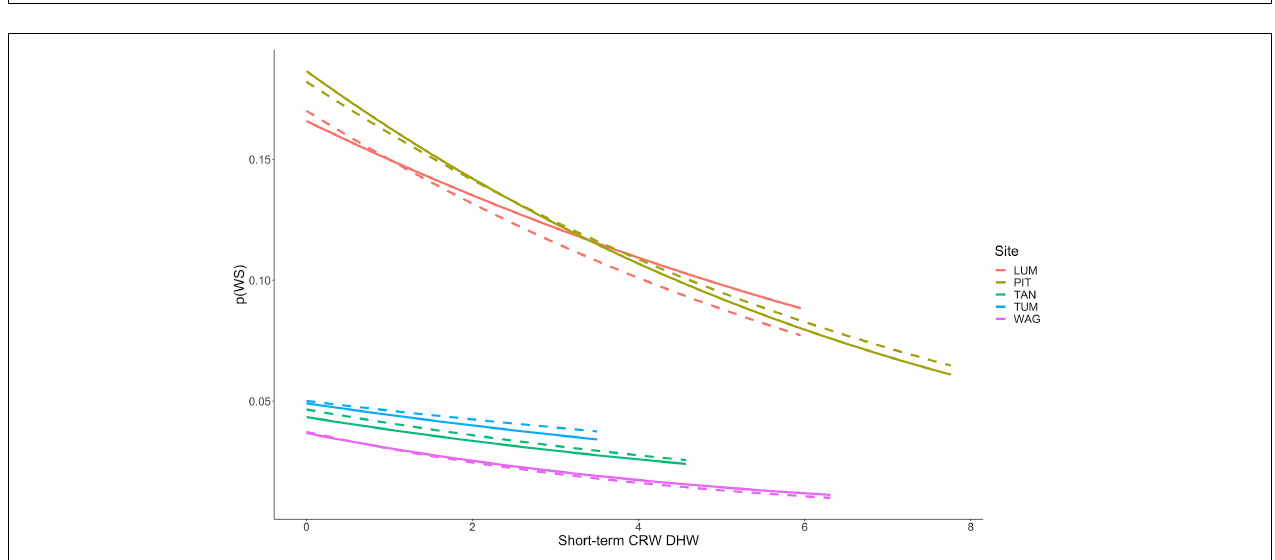
FIGURE 5 | Increasing probability of White Syndrome with increased scaled colony size. Solid lines represent predicted White Syndrome probability on training data, dashed lines represent predictions for reserved data. Species-level plots in Supplementary Figure 7 .